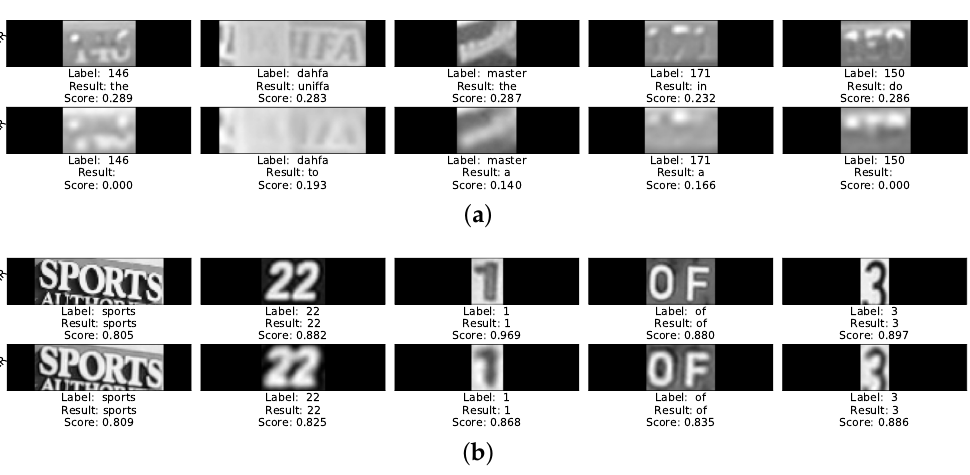
Figure 10. Samples text images from Textzoom with the corresponding quality scores, recognition ground-truth and results. ( a ) shows the paired images with low quality scores in Easy subset. ( b ) shows the paired images with high quality scores in Hard